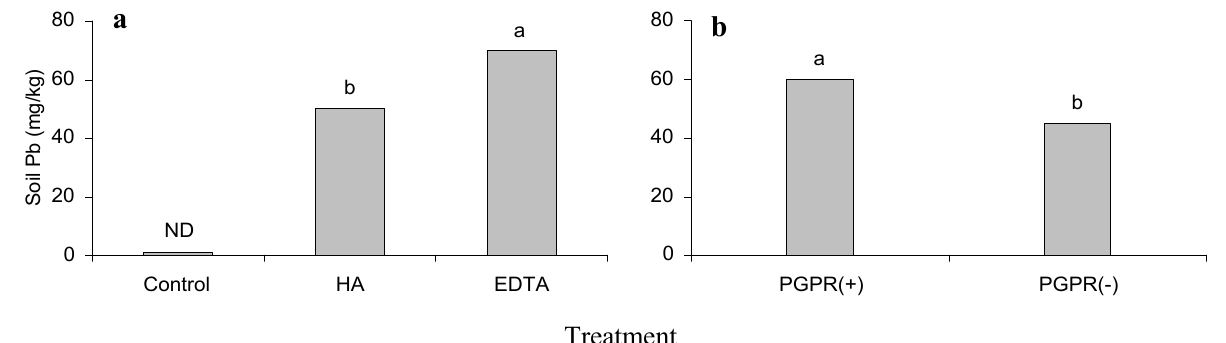
Fig. 1. The simple effect of organic chelates (a) and soil bacterial (b) on soil Pb concentration. HA, ETDA, PGPR (+) and PGPR (-) are humic acid, EDTA chelate and the presence and absence of plant growth-promoting rhizobacteria, respectively